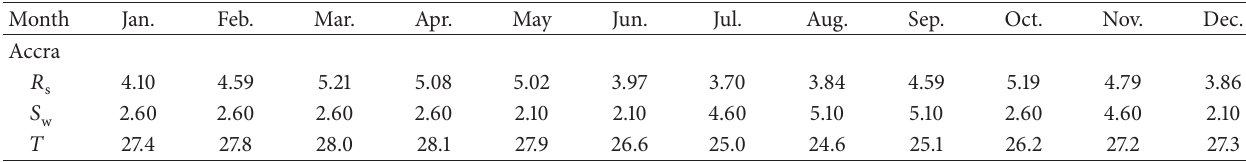
Table 2: Data collected from RETScreen software for the area of Accra (2013).